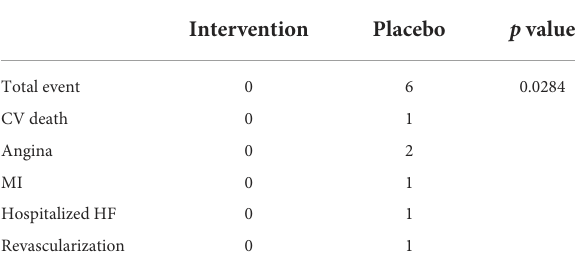
TABLE 3 Clinical outcome at 3 months after initial